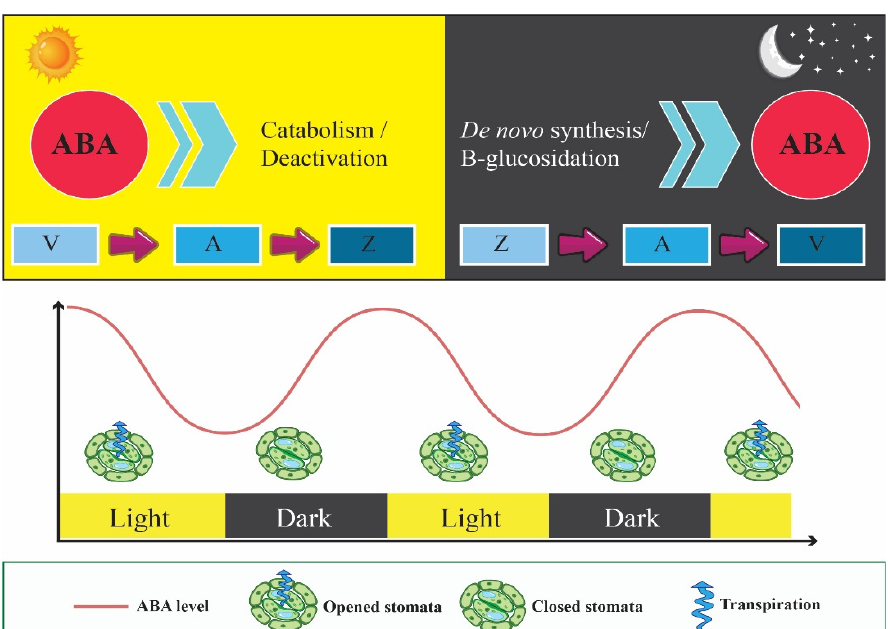
Figure 3. Circadian rhythms in ABA levels and stomatal opening/closure under non-stressful con- ditions. Light period promotes the conversion of violaxanthin (V) into antheraxanthin (A) and then zeaxanthin (Z) in the xanthophyll cycle, leading to ABA catabolism/deactivation and stomatal opening, while darkness favors the production of V as the ABA biosynthesis precursor, and sto- matal closure.